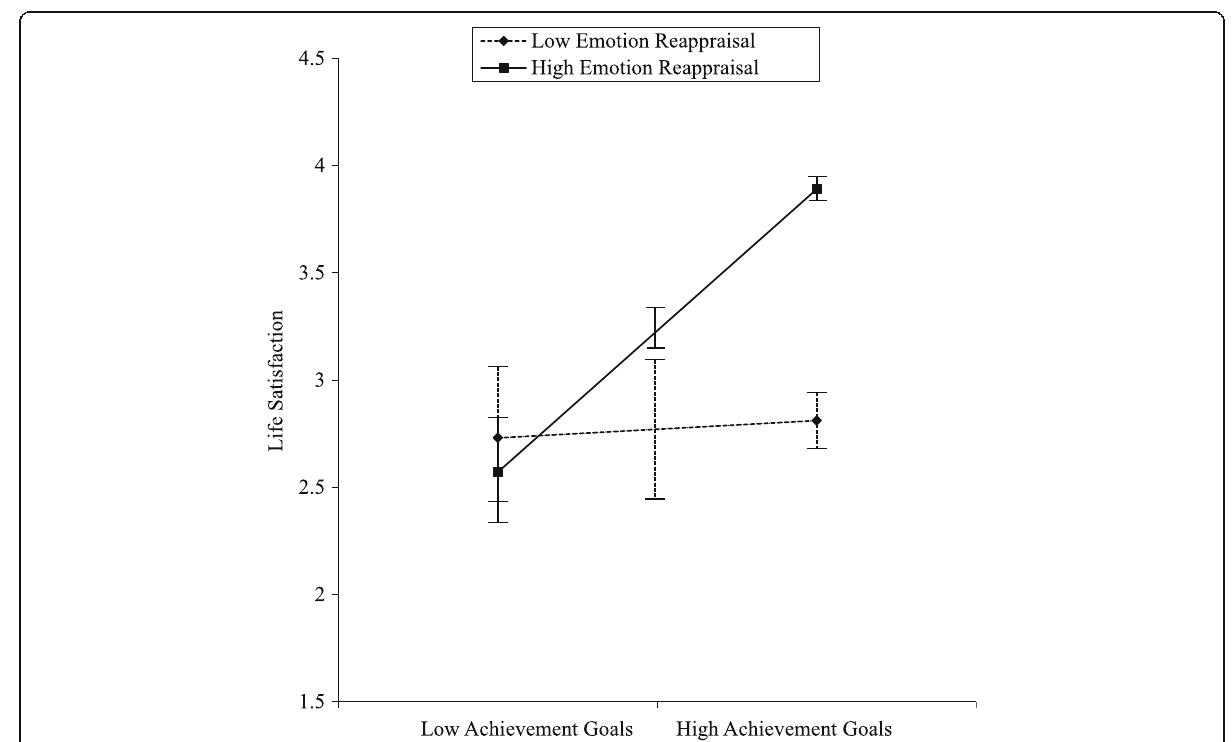
Fig. 1 Simple slope analyses. Moderating effect of emotion reappraisal on the relationship between achievement goals and life satisfaction. Error bars represent standard